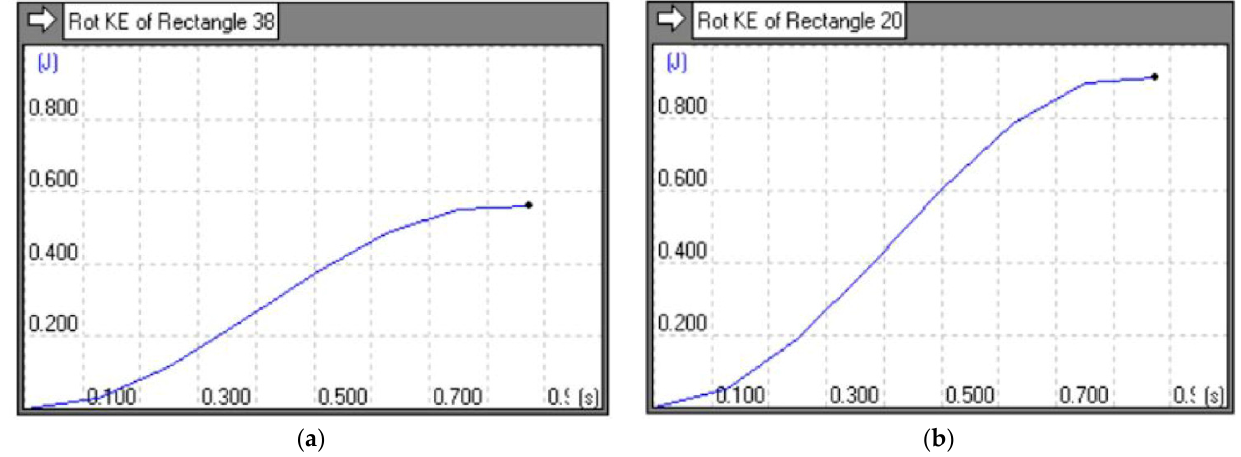
Figure 10. Power consumption: ( a ) with magnetic force, ( b ) without magnetic force.